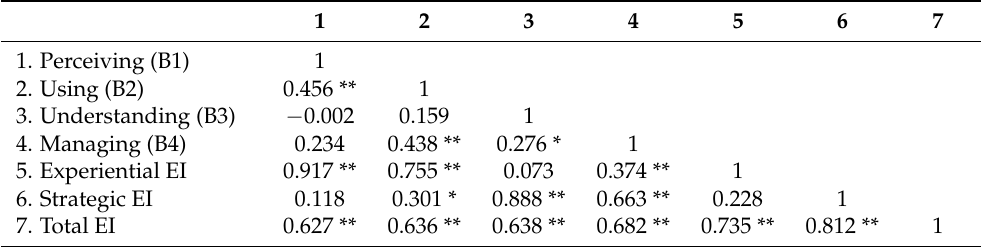
Table 12. Correlations between MSCEIT scores (Study 3).